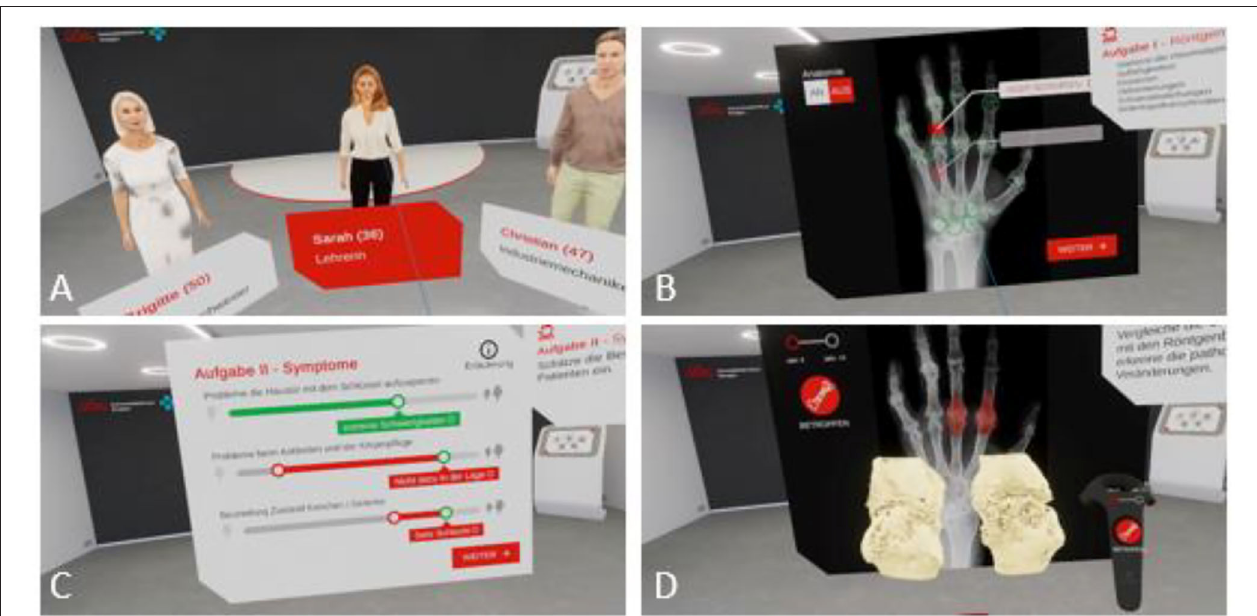
FIGURE 4 | Rheumality-Virtual reality in medical education. Depicted is the welcome scene with the selection of three virtual patients with rheumatoid arthritis and psoriasis arthritis (A) . Users can evaluate the X-ray images of these patients for pathological arthritic changes (B) and assess the disease burden of the patients (C) . The immersion capability of the 3D visualization of arthritis joints allows in-depth inspection of specific disease-related changes (D) .